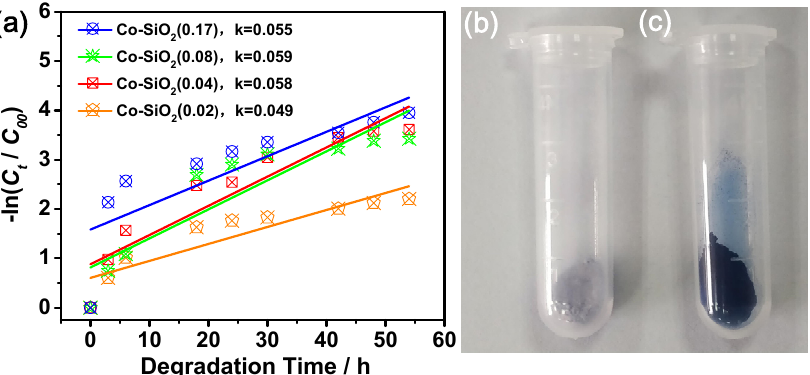
Figure 8. Kinetic curves of MB degraded by Co–SiO 2 catalysts ( a ) and photograph of Co–SiO 2 (0.17) catalyst before ( b ) and after ( c ) the catalytic experiment.